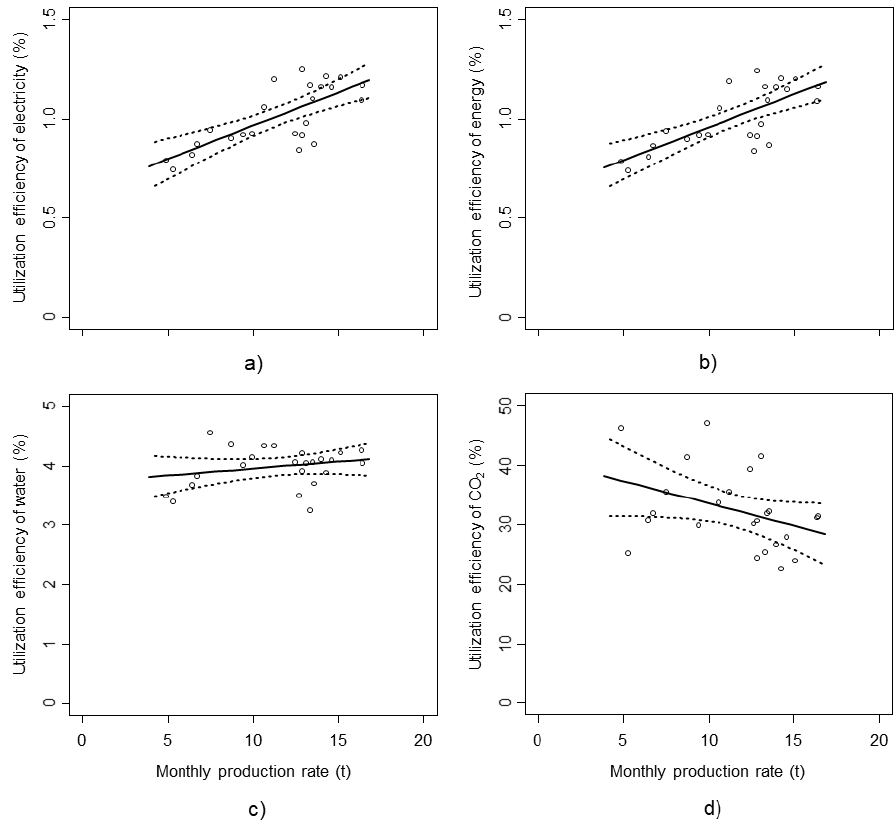
Figure 4. Utilization efficiencies of: ( a ) Electricity; ( b ) energy (electricity + labor); ( c ) water; ( d ) CO 2 as affected by the monthly production rate of lettuce. Regression lines (solid line) are shown with a 95% interval level (dotted lines). Numerical data are presented in Table